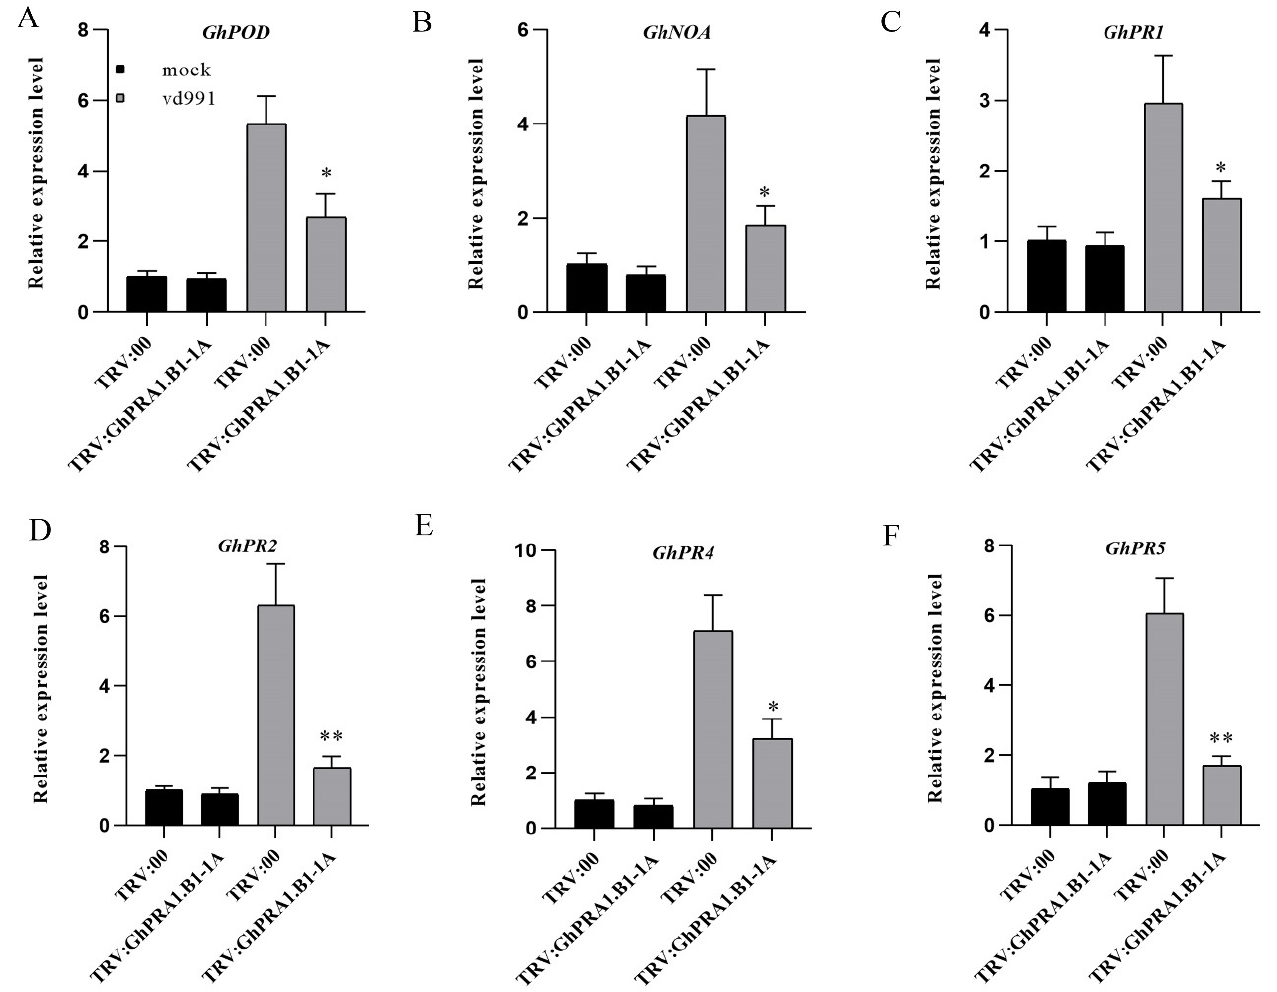
Figure 9. Expression levels of PR genes in GhPRA1.B1-1A -silenced cotton. ( A – F ), RT-PCR analysis of the expression levels of PR genes in silenced plants and controls. All experiments were repeated at least three times (* p < 0.05, ** p < 0.01).